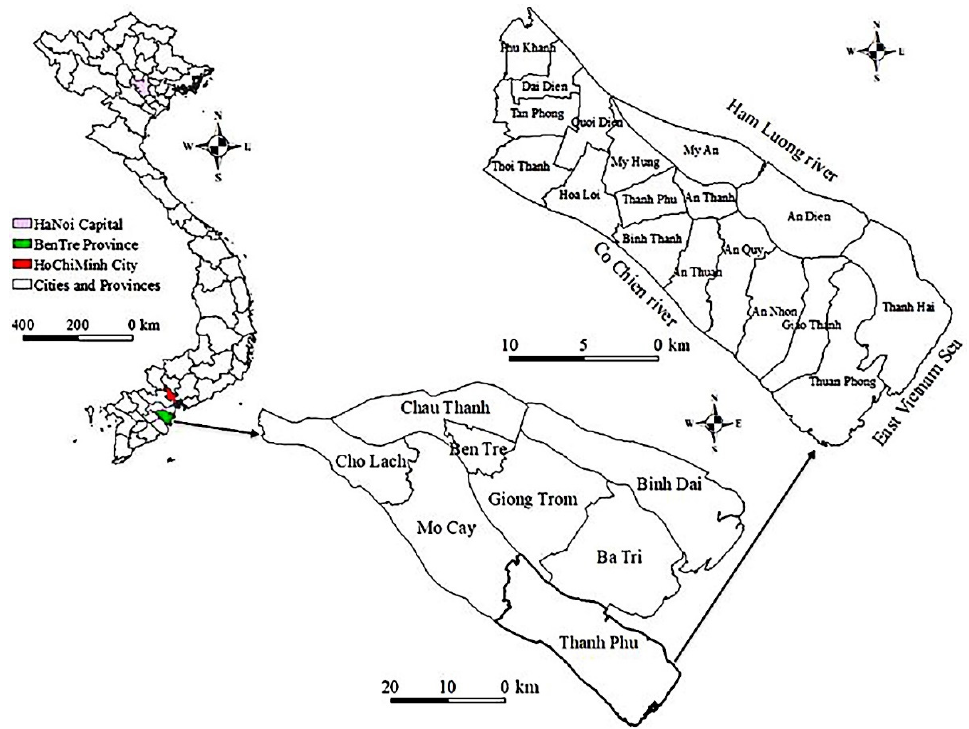
Figure 1. Geographic location of Ben Tre province ( left ), its districts ( middle ), and Thanh Phu district’s communes (created using WGS_1984_UTM_Zone_48N).